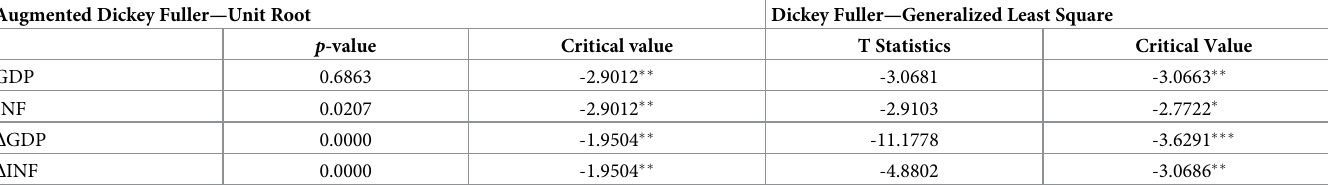
Table 1. Unit root tests for stationarity–GDP and